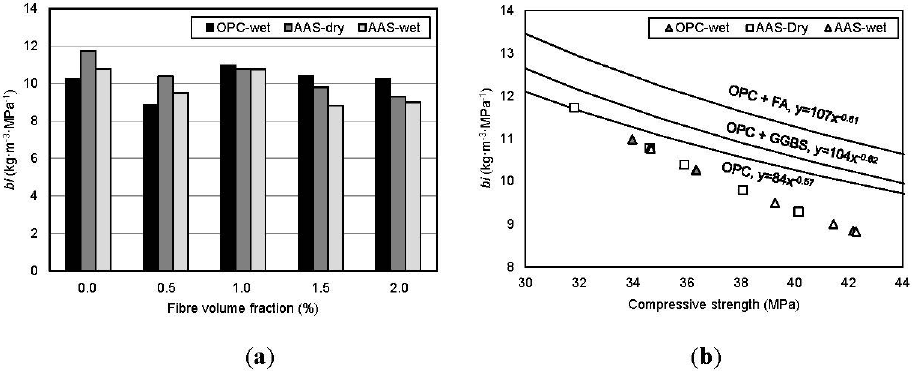
Figure 9. Comparison of binder intensity ( bi ). ( a ) fiber volume fraction; ( b ) compressive strength.